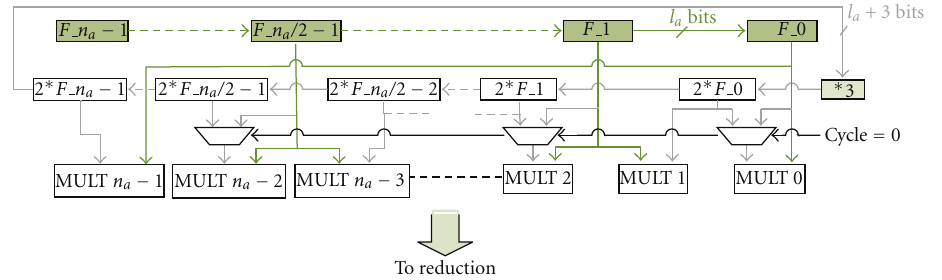
Figure 4: Dedicated squaring architecture.